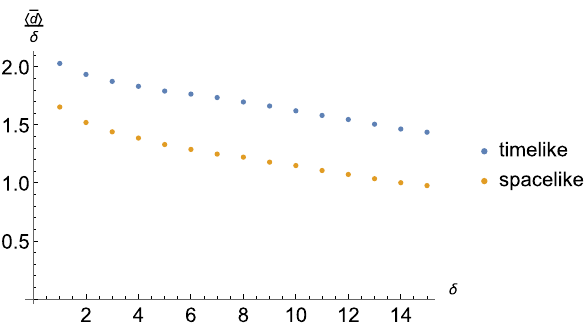
Fig. 6 Normalized average sphere distance (cid:2) ¯ d (cid:3) /δ as a function of the dual linkdistance δ at volume N 41 = 150 k , for sphere centres whichare maximally timelike (blue) or maximally spacelike (yellow) separated (error bars are smaller than dot size)